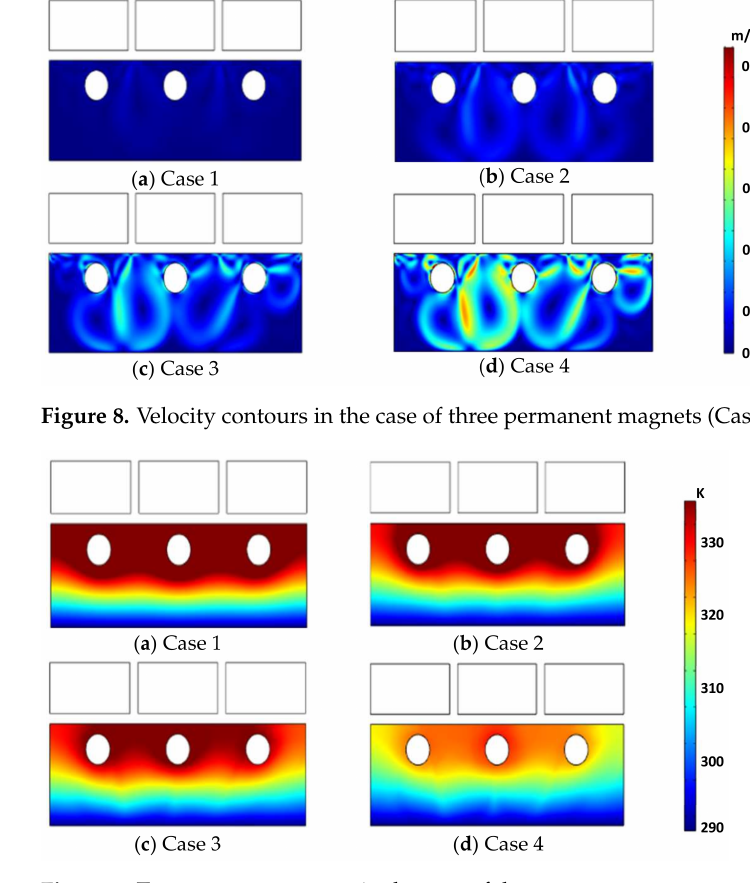
Figure 9. Temperature contours in the case of three permanent magnets (Case C). Table 5. Temperature values in the case of three permanent magnets (Case